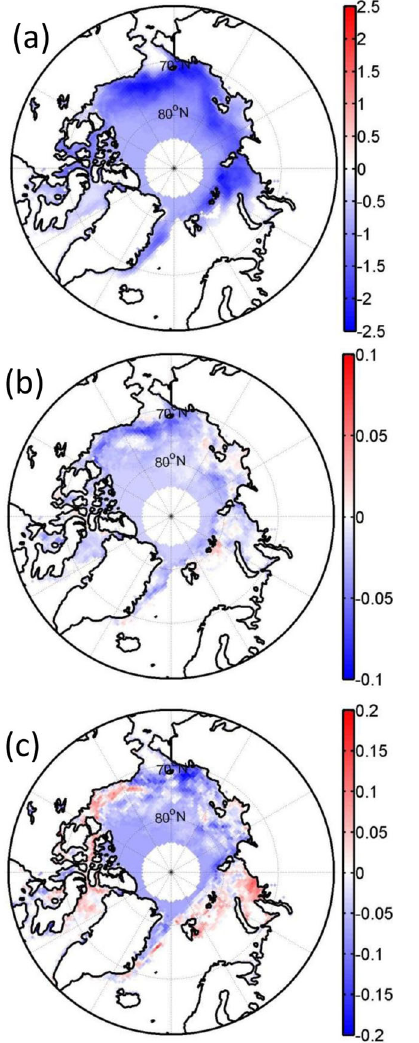
Fig. 9 The thermodynamic ( a ), dynamic ( b ), and interaction ( c ) contribution to total trends in the August – October Arctic sea ice days from all 12 SOM nodes (units: day yr − 1